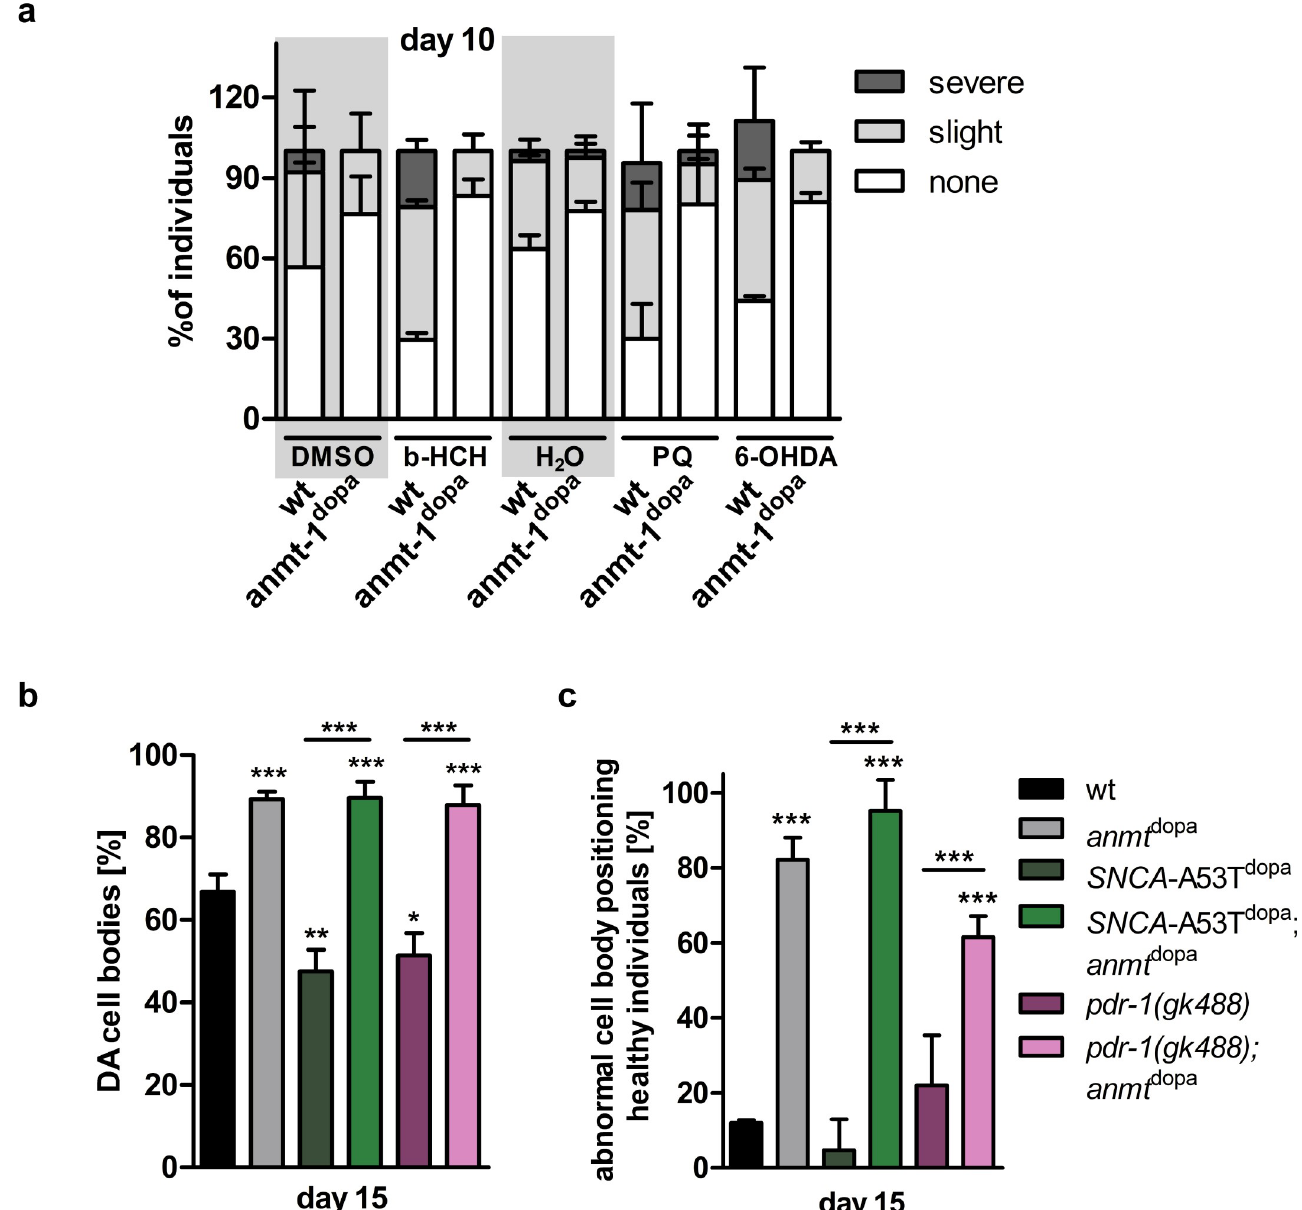
Fig 7. anmt-1 dopa rescues DA neurodegeneration in toxin-induced and genetic C . elegans models of PD. a DA neuronal morphology of wt and anmt-1 dopa categorized in no (white), slight (light grey), and severe (dark grey) treated with β -hexachlorocyclohexane ( β -HCH; 1 mM) compared to DMSO, paraquat (PQ; 300 μ M) and 6-hydroxydopamine (6-OHDA; 1mM) compared to water at 10 days of adulthood. See S1 Table for statistics. b Presence of (DA) cell bodies in anmt-1 dopa (grey), SNCA- A53T dopa (dark green), SNCA- A53T dopa ; anmt-1 dopa (green), pdr-1(gk488) (purple) and pdr-1(gk488);anmt-1 dopa (light purple) compared to wt (black) at day 15 of adulthood. c Abnormal DA cell body positioning at day 15 of adulthood. � : p < 0.05, �� : p < 0.01, ��� : p < 0.001.